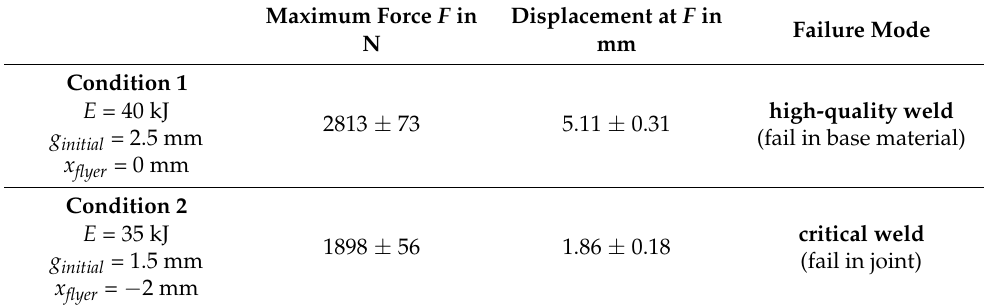
Table 3. Results of the lap shear test and resulting failure mode for Condition 1 and Condition